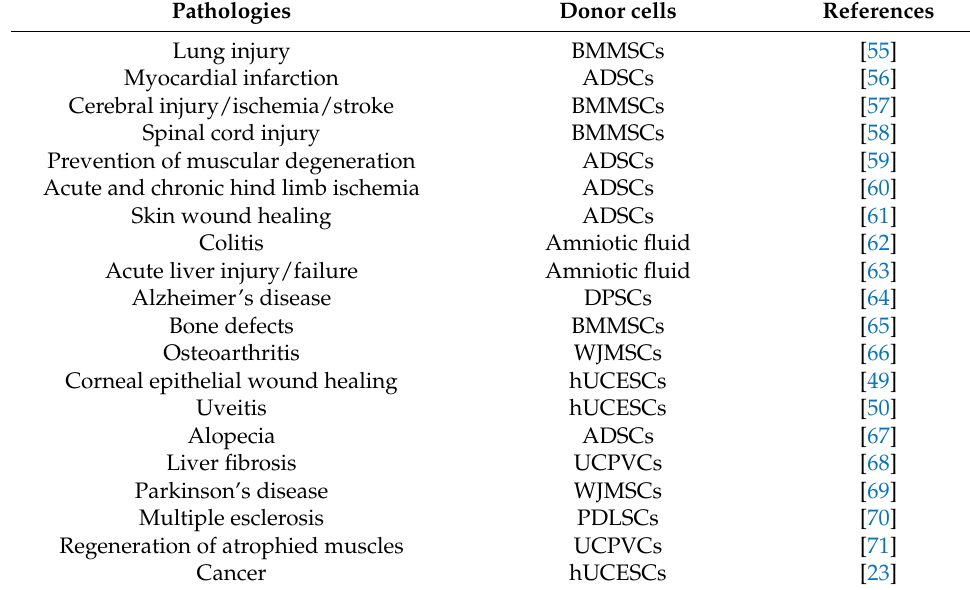
Table 1. Studies involving the use of mesenchymal stem cells-conditioned medium (MSC-CM).